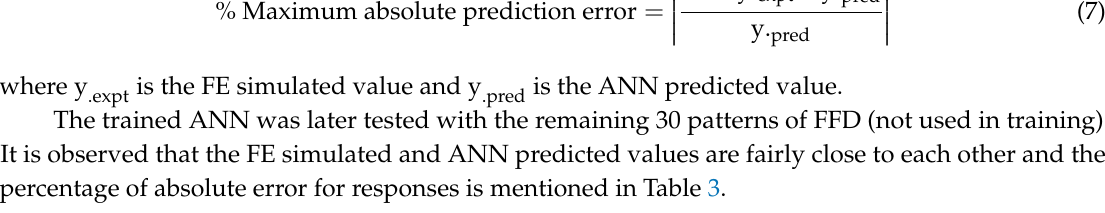
e ff ective strain ( (cid:15) e ff . ), e ff ective strain rate ( (cid:15) rate. ), and punch force (F) were compared with concerned